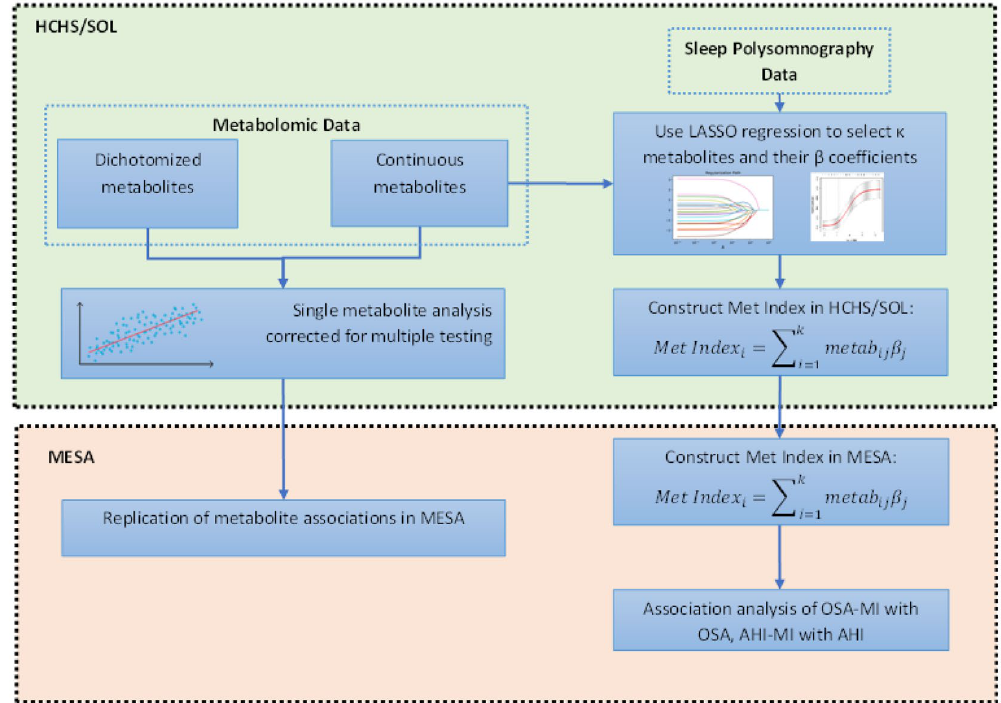
Figure 1. Study design flow chart. Abbreviations: LASSO least absolute shrinkage and selection operator, HCHS/SOL the Hispanic Community Health Study/Study of Latinos, MESA the Multi-Ethnic Study of Atherosclerosis, Met Index metabolite index, metab